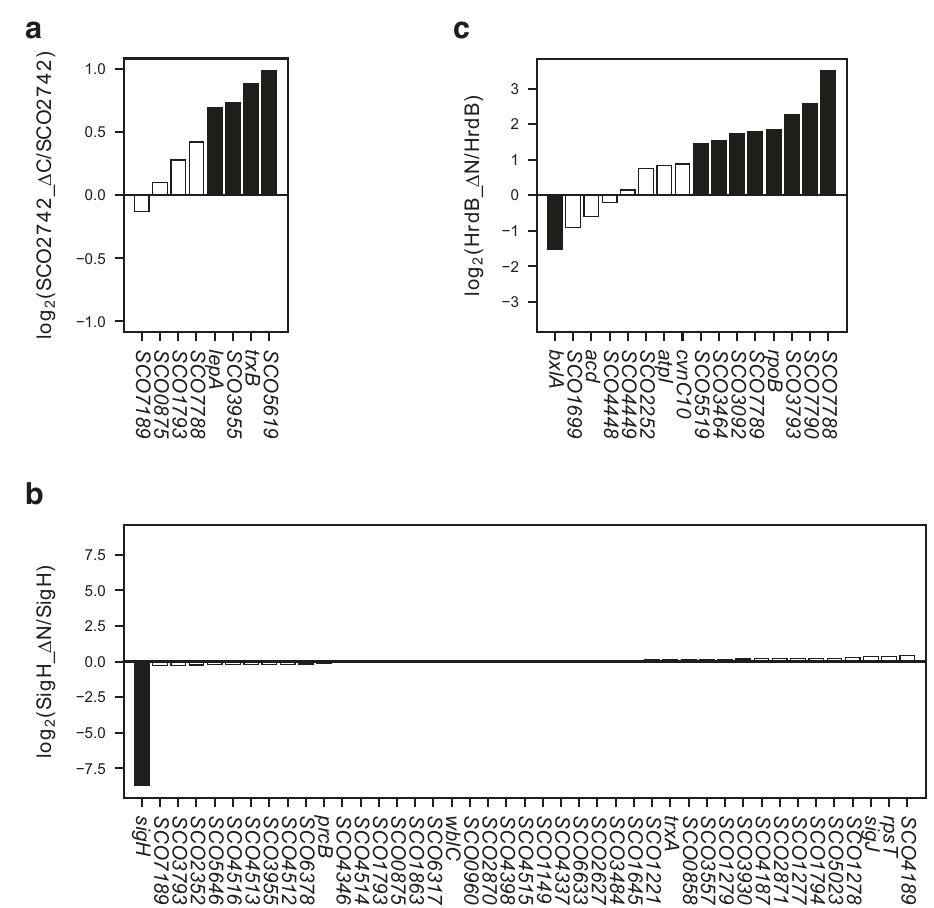
Fig. 3 Relative transcript abundances generated by the truncated and full-length sigma factors. Y axis indicates the relative abundance of the transcripts generated by the truncated sigma factor compared to the transcript abundance generated by the full-length form of the sigma factor. a Relative transcript abundances of the target genes of SCO2742. b Relative transcript abundances of the target genes of SigH. c Relative transcript abundances of the target genes of HrdB. Filled bars, adjusted P value < 0.01; open bars, adjusted P value ≥ 0.01. Fold changes and adjusted P values were determined by using the DESeq2 (Fig. 3c). Previously, two forms of HrdB were observed in S.